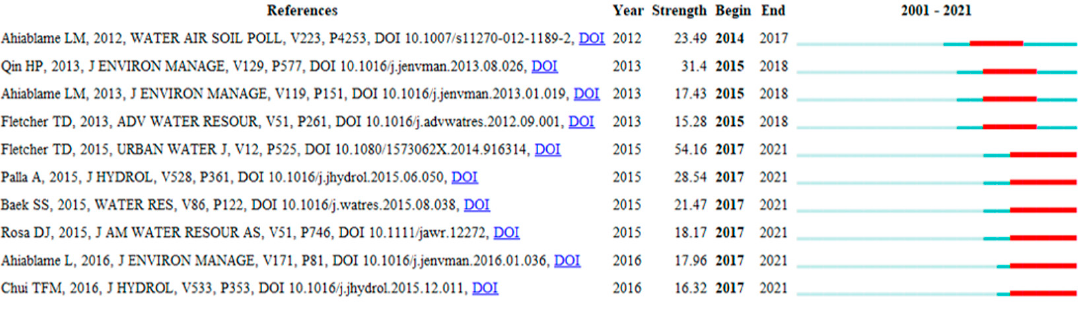
Figure 9. Top ten references with the strongest citation bursts.